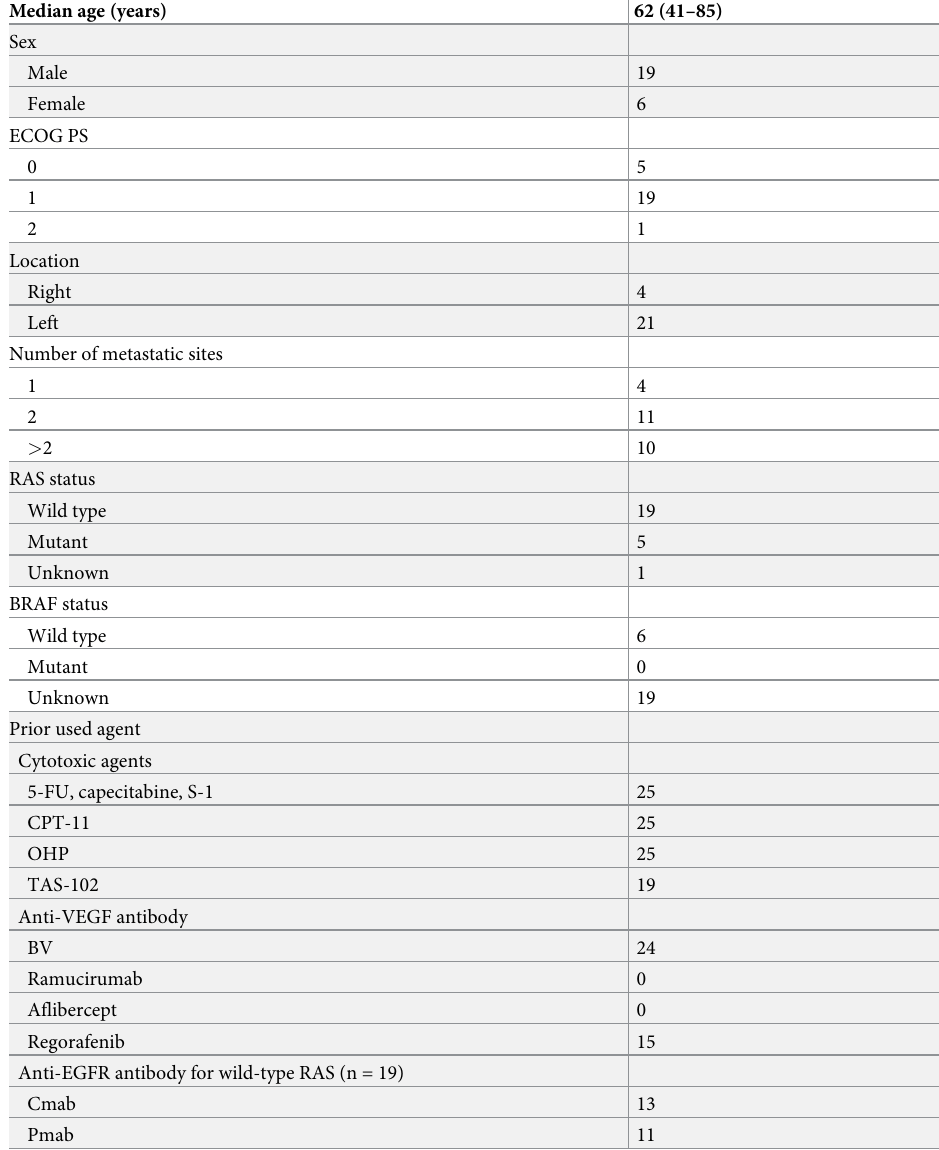
Table 1. The median age was 62 years. 76% of the patients were male. Most of the patients had an Eastern Cooperative Oncology Group PS of 0 or 1 (96%) and a left-side primary tumor (84%). The RAS status was wild and the BRAF status was unknown in 76% of the patients. The clinical courses of the initial Re-Cx chemotherapy regimens in the 30 cases are shown in Table 2. Collectively, the response achieved during initial Re-Cx was complete response (CR) in 1 case (3%), partial response in 12 cases (40%), stable disease in 10 cases (33%), PD in 1 case Table 1. Background information of the 25 patients at the initiation of